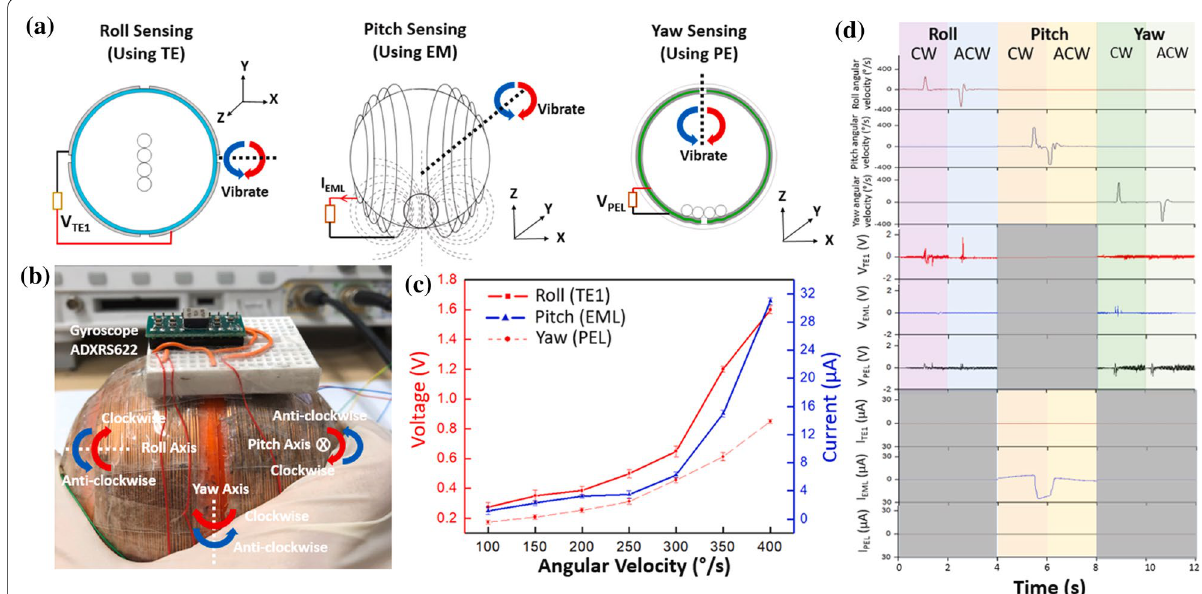
Fig. 12 a Illustration of the application of TENG voltage in roll-sensing, EMG current in pitch-sensing and PENG voltage in yaw-sensing b prototype of the 3DAIS integrated with gyroscope c output current and voltage variation with angular velocity in yaw, roll, and pitch motions d profiles of angular velocities and output voltage from the hybrid EMG-TENG-PENG sensor for anticlockwise and clockwise roll, yaw and pitch movements, [37] (Images are re-used with the permission of the